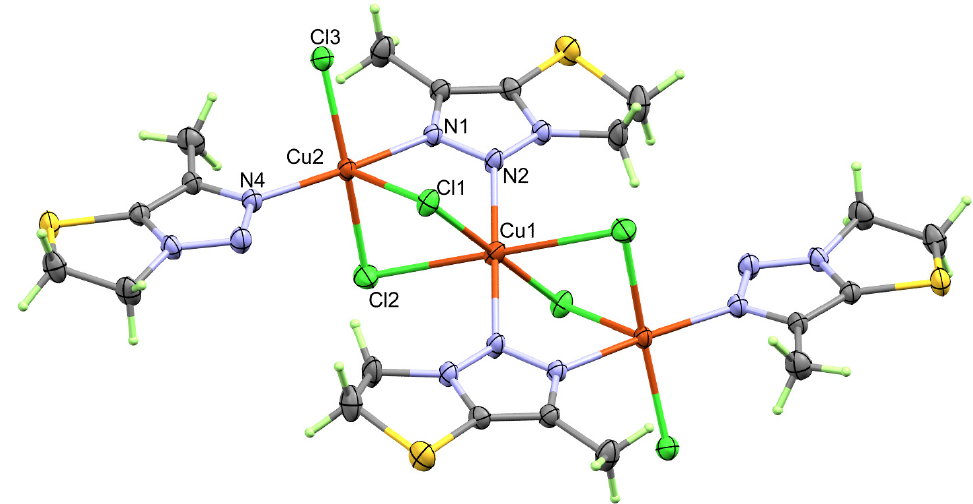
Figure 2. The structure of the trinuclear [Cu 3 (L a ) 4 (Cl) 6 ] complex. Table 2. The important geometric parameters in the [Cu 3 (L a ) 4 (Cl) 6 ] complex. Bond